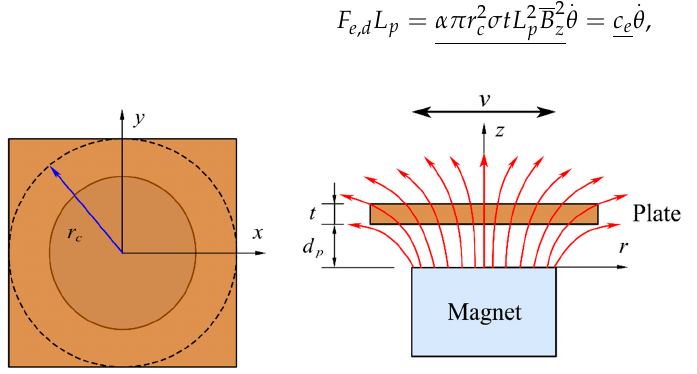
Figure 6. Schematic of the eddy current damper.